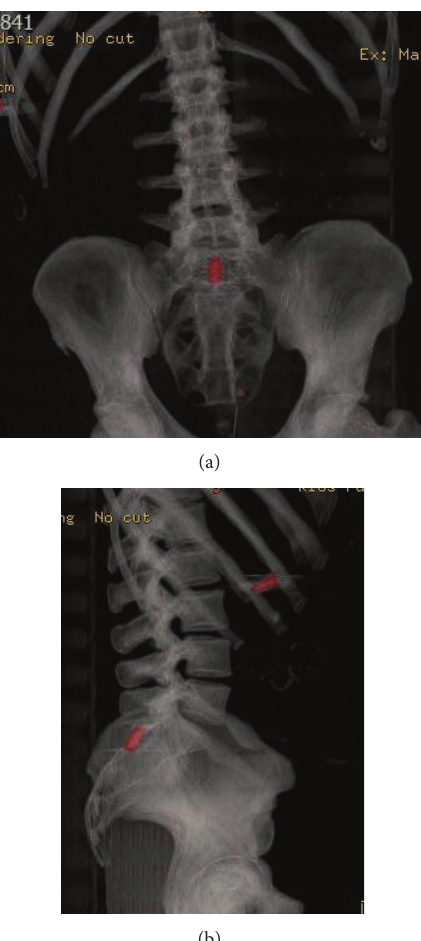
Figure 3: 3D CT scan